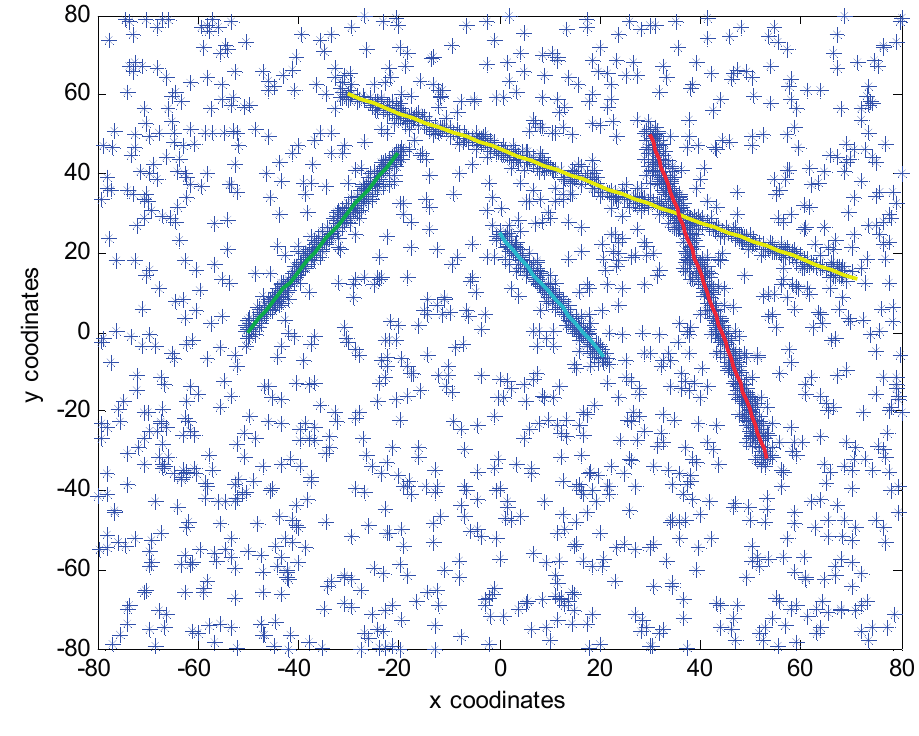
Figure 2. True trajectories and